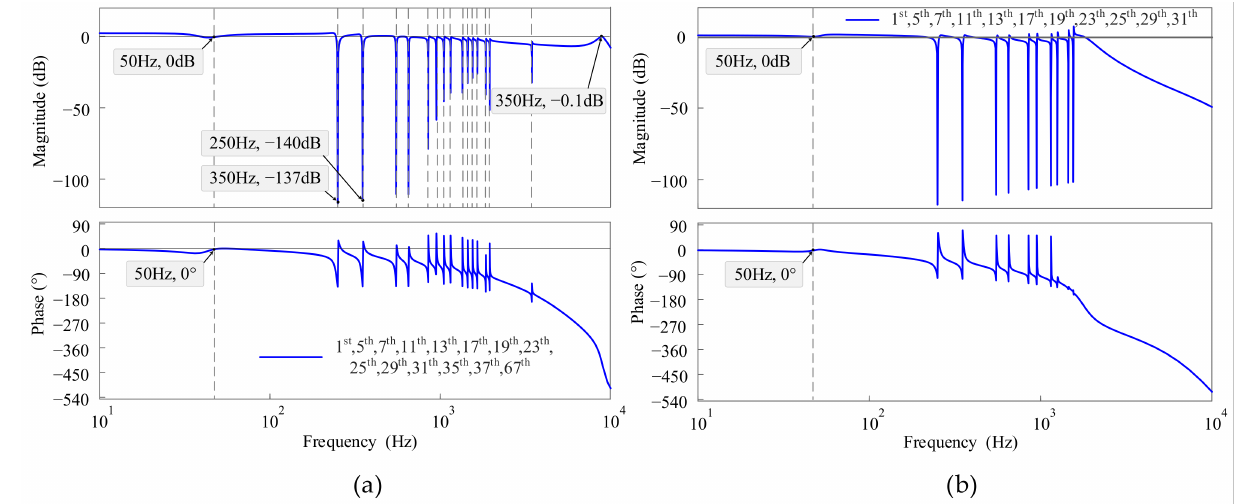
Figure 25. Bode plots of the closed-loop transfer function G cl_pro ( s ): ( a ) L g = 0; ( b ) L g = 2.6 mH.